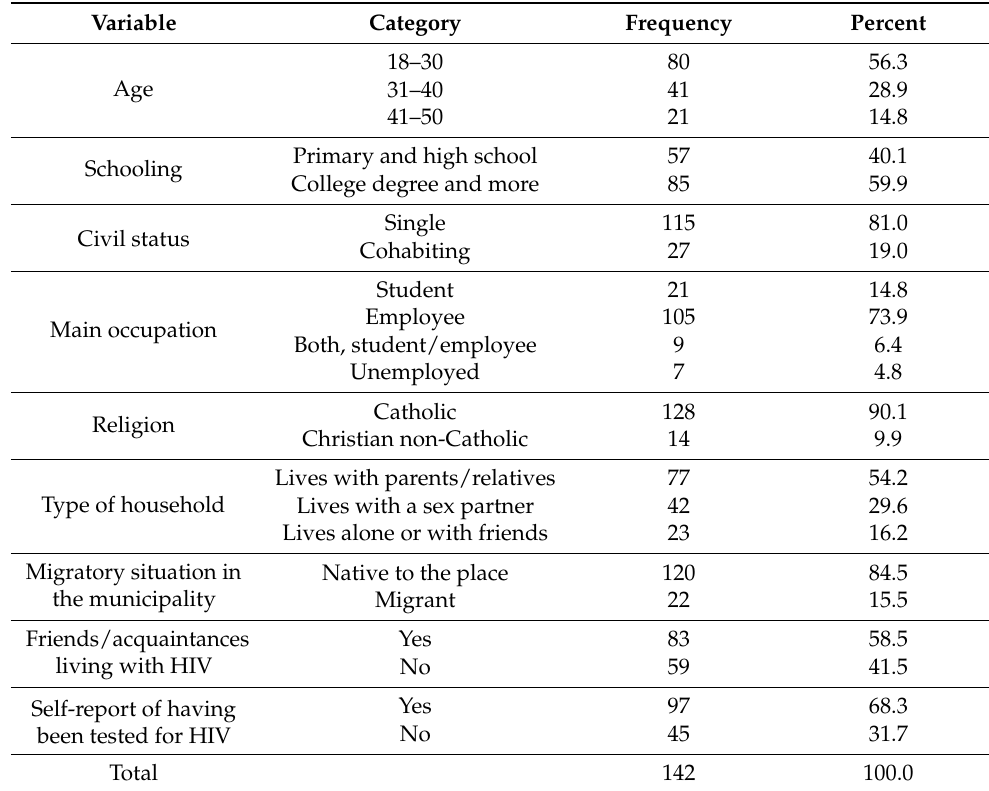
Table 1. Sociodemographic characteristics of the interviewed men who have sex with men, Manzanillo,